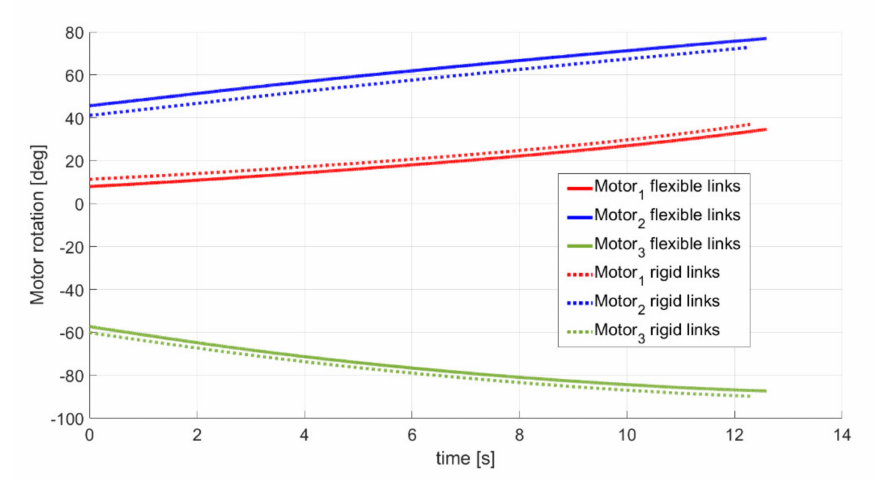
Figure 11. Motor joint variable set in the case of robot with flexible and rigid links. During the simulation, the maximum moments acting on the links are identified and compared to the experimental data to find the minimum internal pressure required to ensure the validity of the model. Supposing both links have same features and internal pressure, having on the link 1 a maximum moment of τ max = 17.51 Nm, resulting from the combination of the torques acting on the two orthogonal virtual springs, the pressure should be p ≥ 50